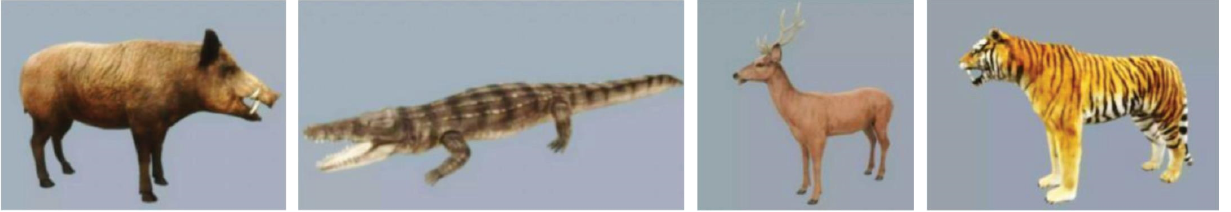
F IGURE 3: Samples of the animal